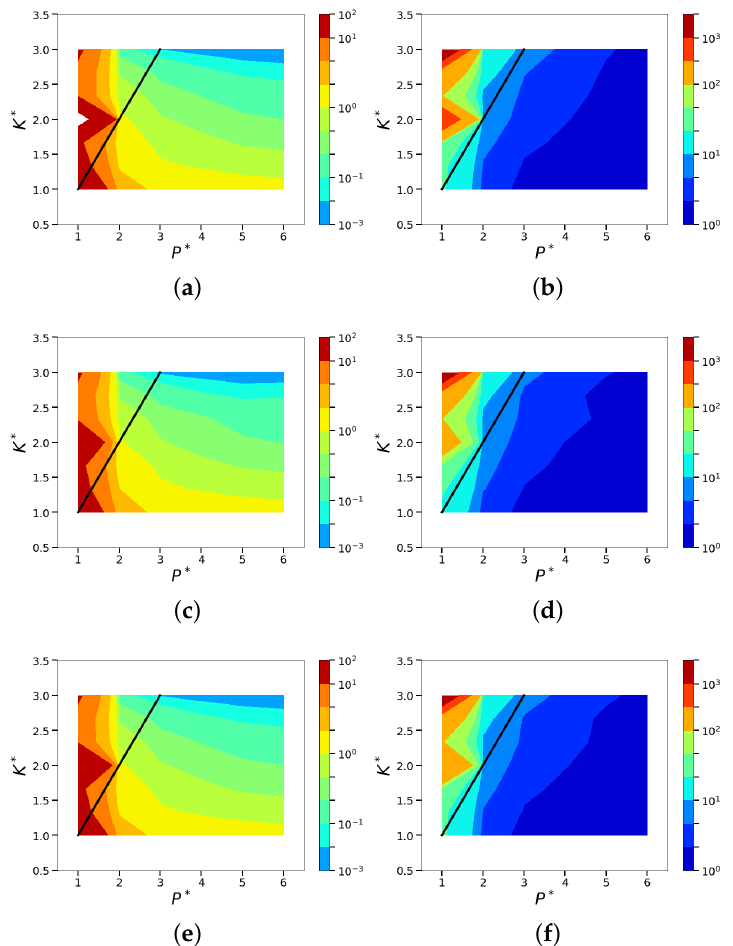
Figure 12. Isocontours of the normalized mean squared ( l 2 ) ELM-based sparse reconstruction errors for the maximum, minimum, and average using different choices of the random input weights. Left: normalized absolute error metric, (cid:101) 1 . Right: normalized relative error metric, (cid:101) 2 . ( a ) (cid:101) 1 (maximum); ( b ) (cid:101) 2 (maximum); ( c ) (cid:101) 1 (minimum); ( d ) (cid:101) 2 (minimum); ( e ) (cid:101) 1 (average); and ( f ) (cid:101) 2